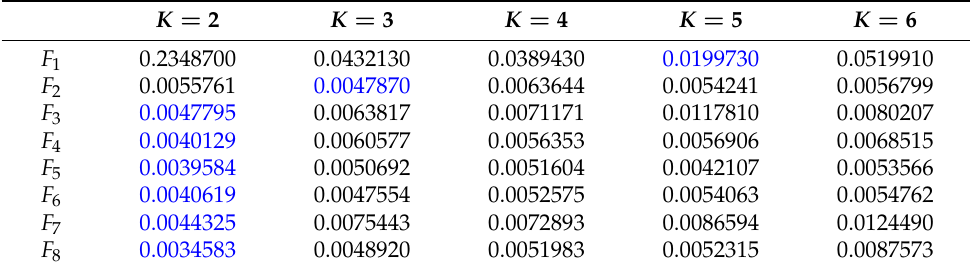
Table 3. Processing time in seconds using k-means (best values in